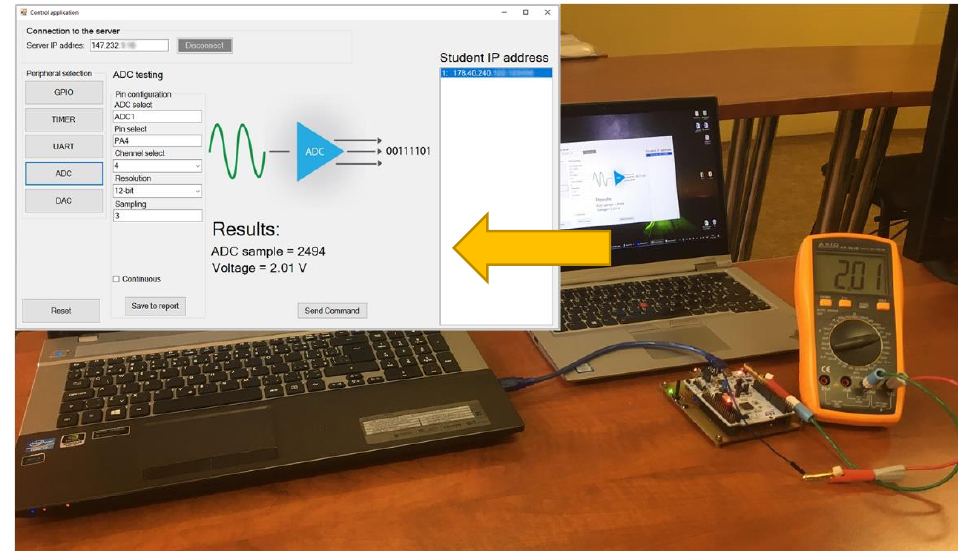
Figure 13. ADC peripheral testing.